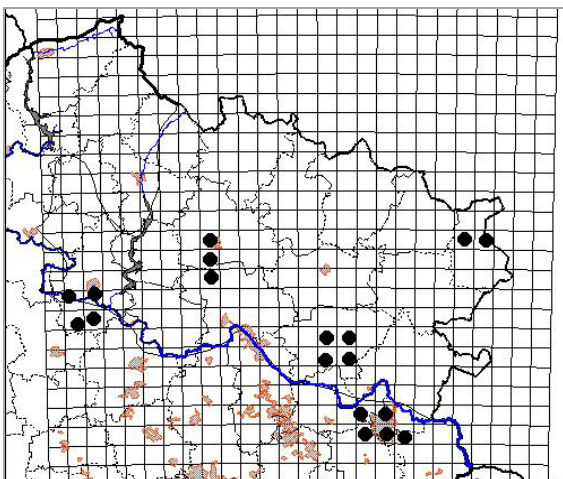
Fig. 27. The map of the distribution of Ulmus pumila L. in the Starobilsk grass-meadow